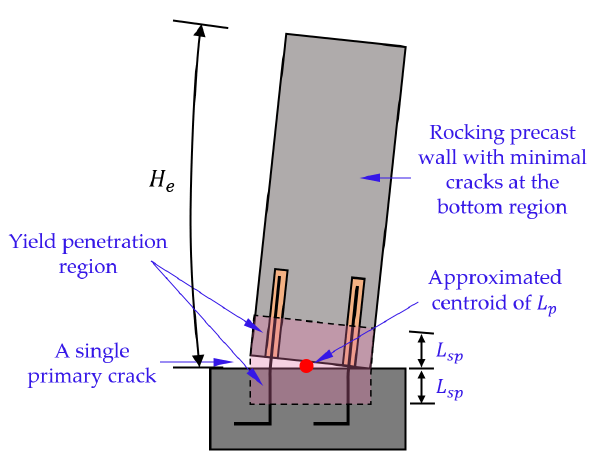
Figure 11. The phenomenon of yield penetration and plastic